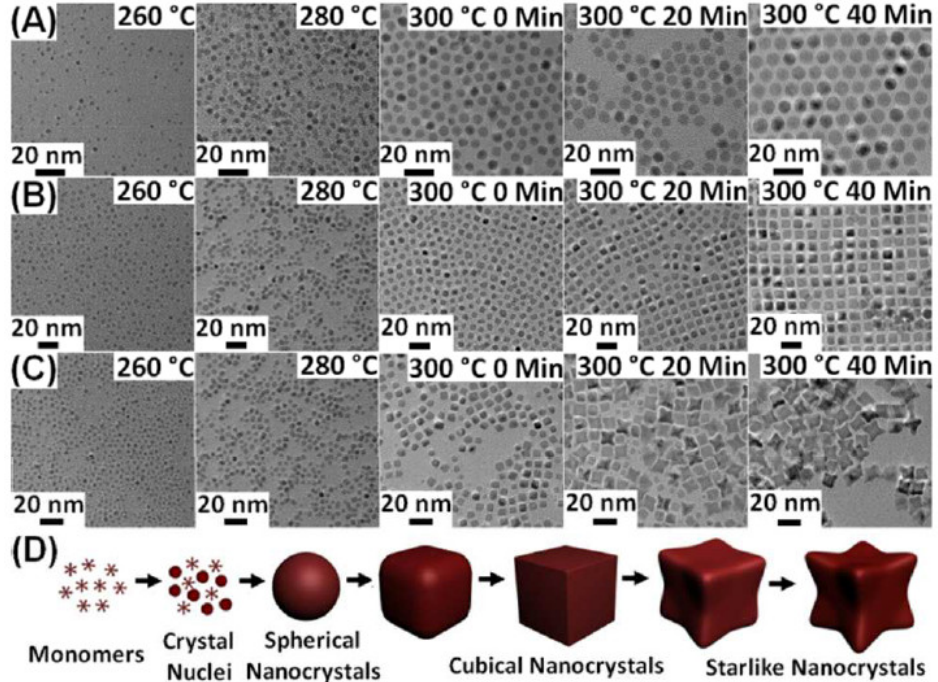
Figure 5. TEM micrograph of Mn-Zn ferrite nanocrystals collected from the reaction mixture at 260 ◦ C, 280 ◦ C, and 300 ◦ C following aging for 0, 20, and 40 min. ( A ) spherical ( B ) cubical, and ( C ) starlike. ( D ) Evolution of the shape of starlike nanocrystals shown schematically. Reproduced with permission from [62] Copyright (2013) American Chemical Society.